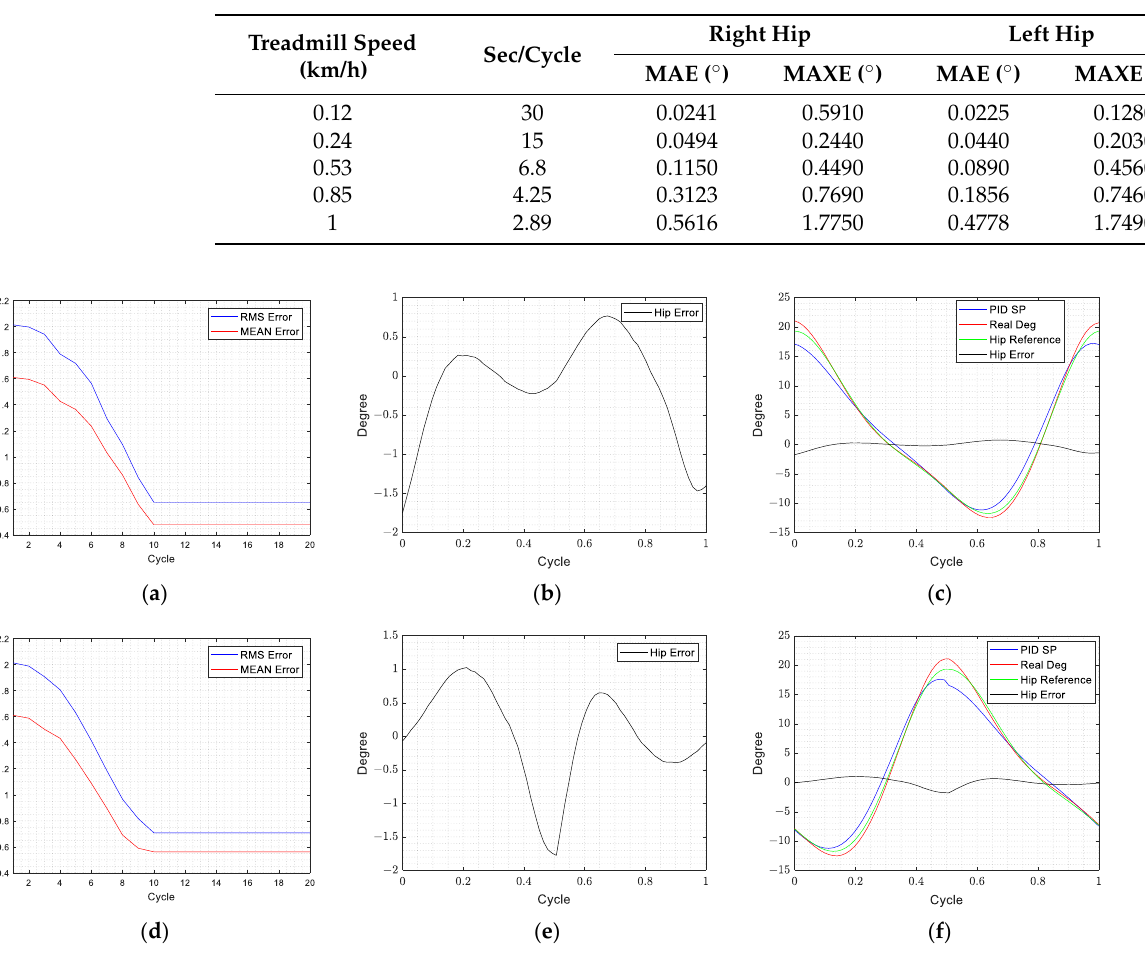
Figure 11. Control system of ILC with PID controller. Table 3. Tracking error of hip joint using ILC with PID controller.